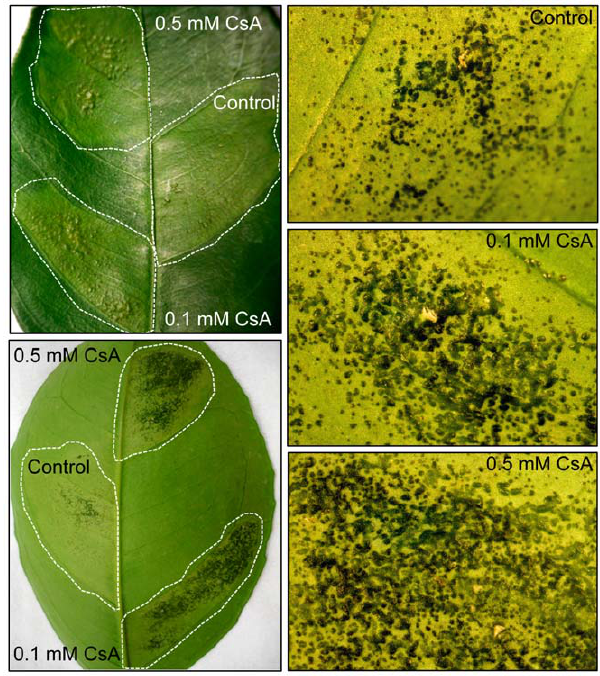
Figure 6. Effect of CsA on citrus canker development. Sweet orange leaves were infiltrated with X. citri (approximately 2.0 6 10 4 cells) in the absence or presence of CsA at 0.1 or 0.5 mM. Canker lesions started to develop one week after bacterial infiltration and were pronounced 14 days after bacterial inoculation, when the pictures were taken (20 6 magnification). Left panels show representative leaf sectors that were infiltrated with water suspensions of X. citri plus CsA at 0.1 or 0.5 mM final concentrations, or X. citri alone, as control (dotted lines). CsA substantially increased pustule formation and symptom develop- ment including tissue hypertrophy and water-soaking, relative to control. The effect of CsA on canker development was dose-dependent as 0.5 mM CsA induced more confluent pustules than 0.1 mM CsA or no CsA (right panels).